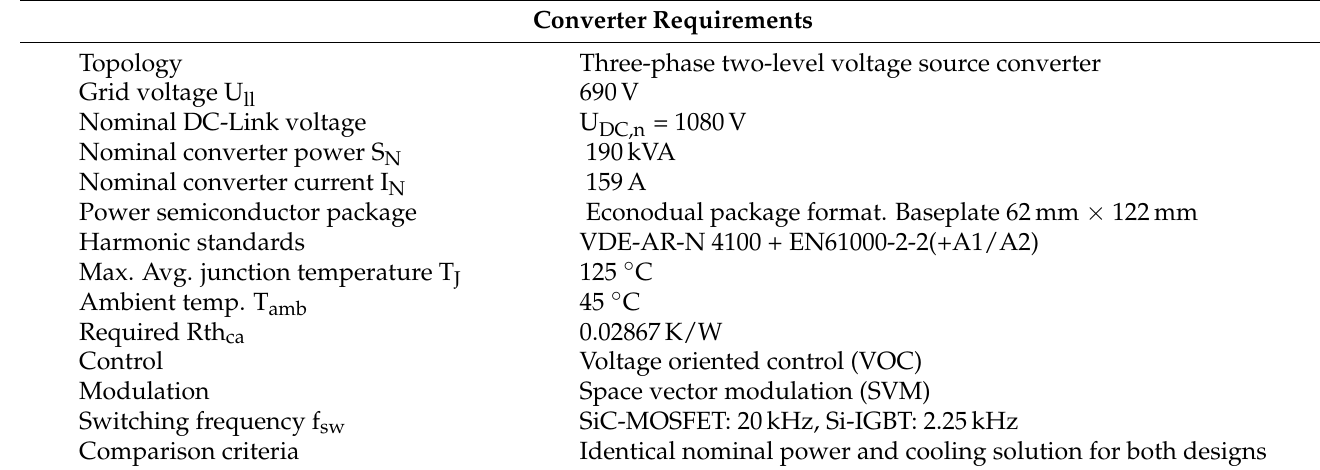
Figure 1. Circuit configuration of the proposed active front end for comparison purposes: the grid-tied 2L-VSC with LCL-Filter. Table 1. Main converter requirements and